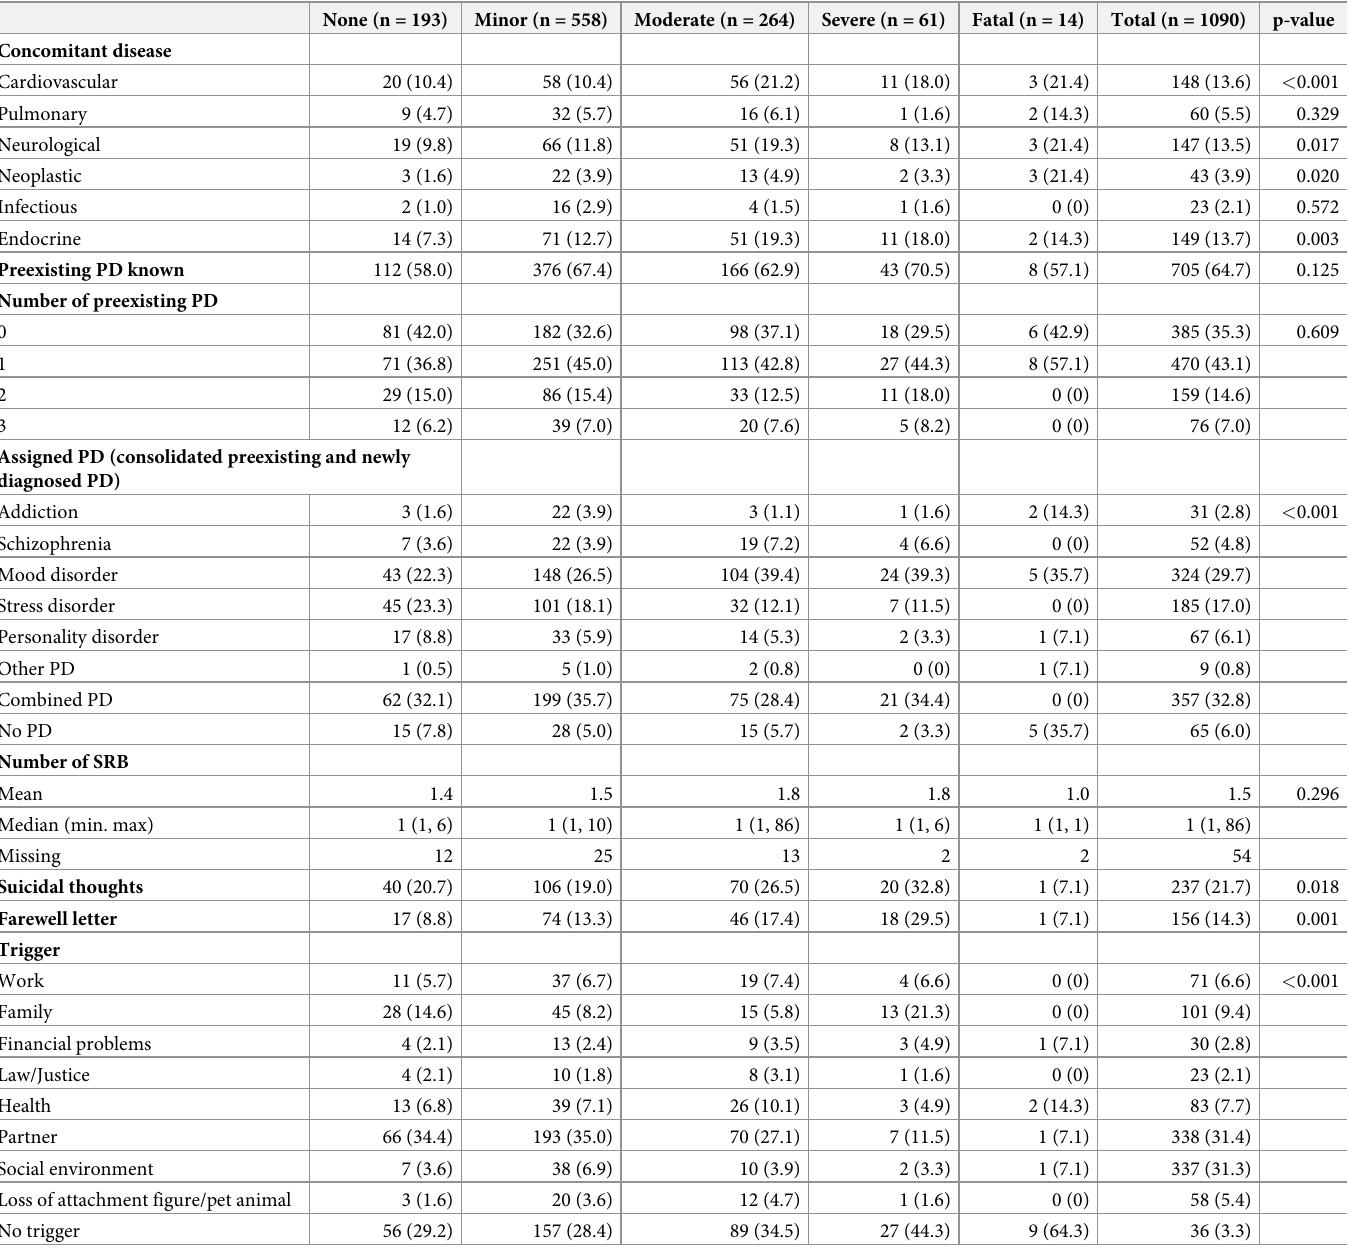
Table 2. Relationship between patient related information and severity of